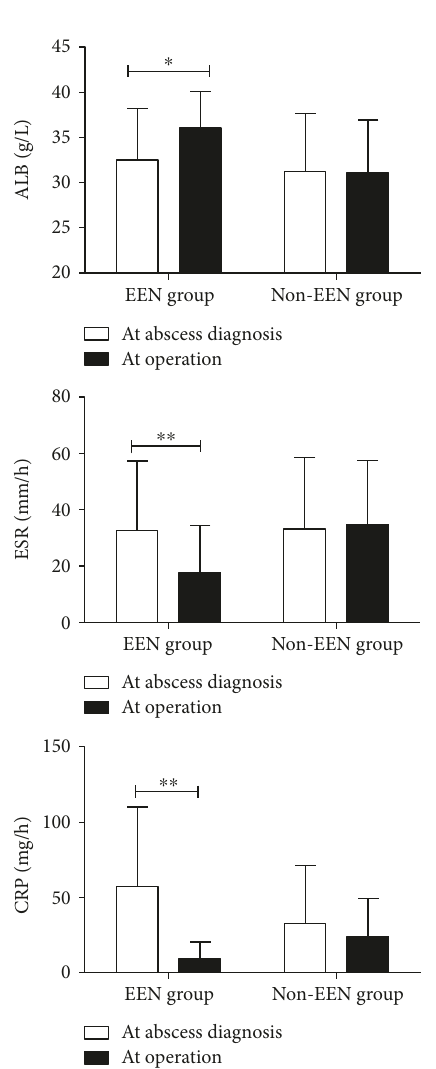
Figure 2: Comparison of the levels of albumin, erythrocyte sedimentation rate (ESR), and C-reactive protein (CRP) at abscess diagnosis and at operation in both groups of patients who underwent surgery later ( ∗ P < 0 05 , ∗∗ P < 0 001